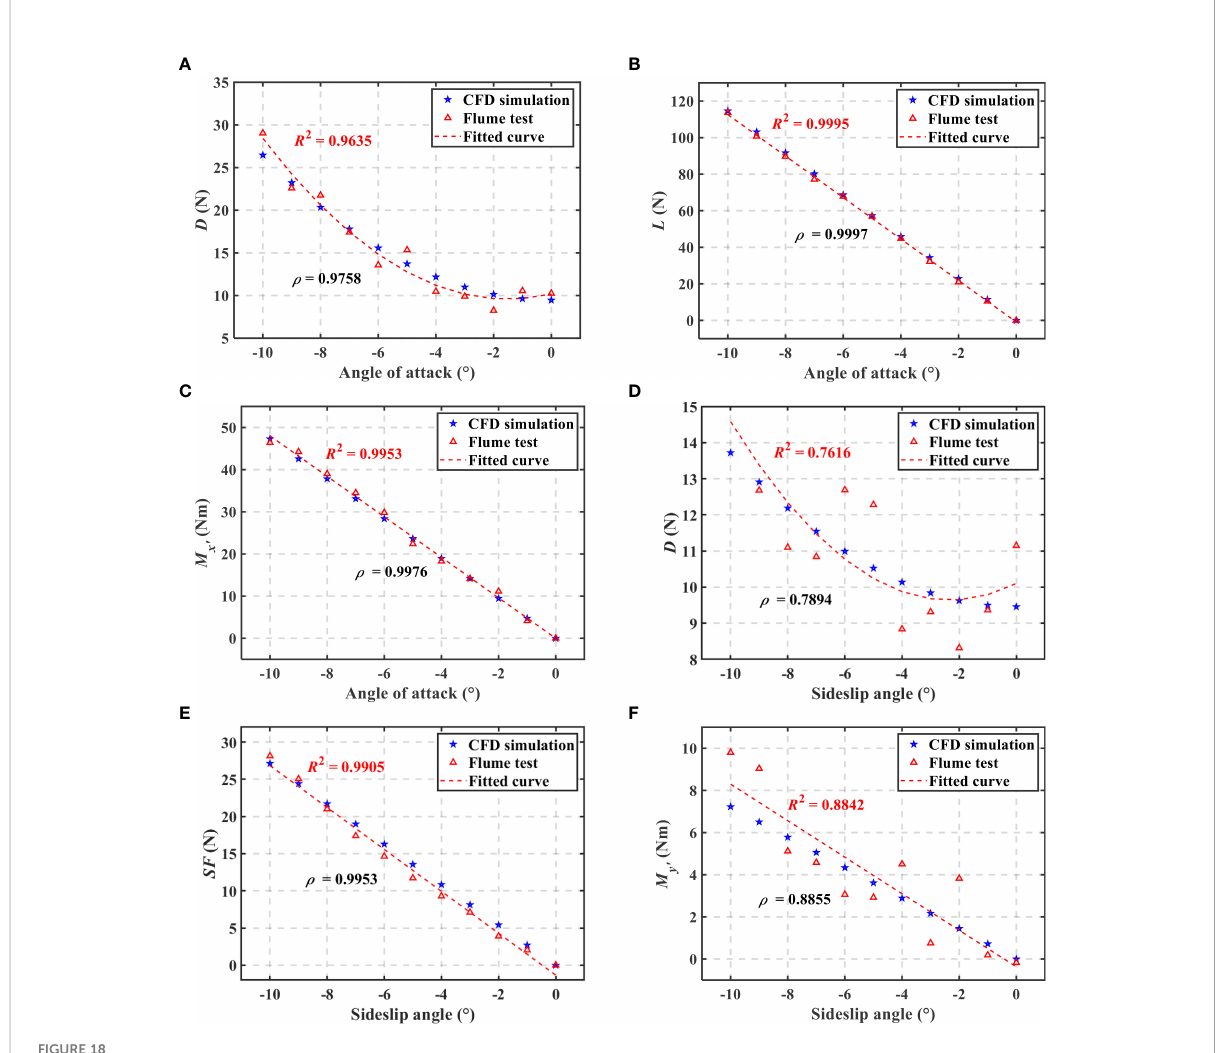
FIGURE 18 Results of circulating fl ume test and CFD